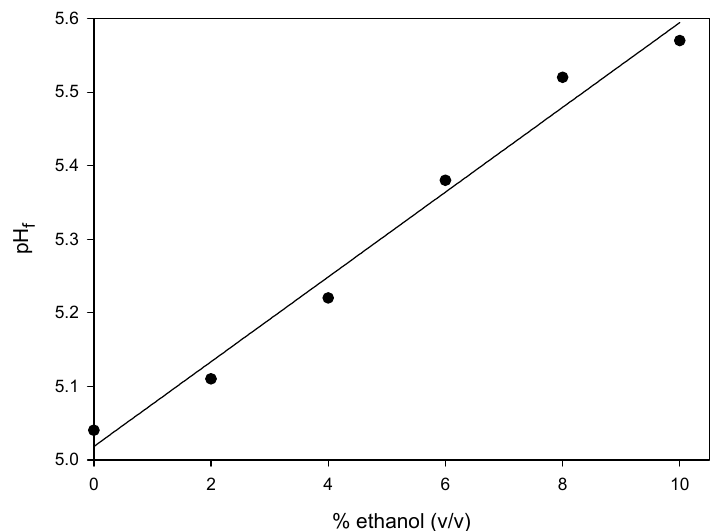
Figure 2. The DWS traces of reconstituted skim milk (100 g L − 1 milk solids) containing 0 (- ● -), 2 (- ○ -), 4 (- ▼ -), 6 (- ▽ -), 8 (- █ -), or 10 (- □ -) % ethanol as a function of pH during incubation with 25 g L − 1 GDL at 32 °C. Values are the means of experiments on three individual milk samples. The coefficient of variation was less than 5% for all data points.